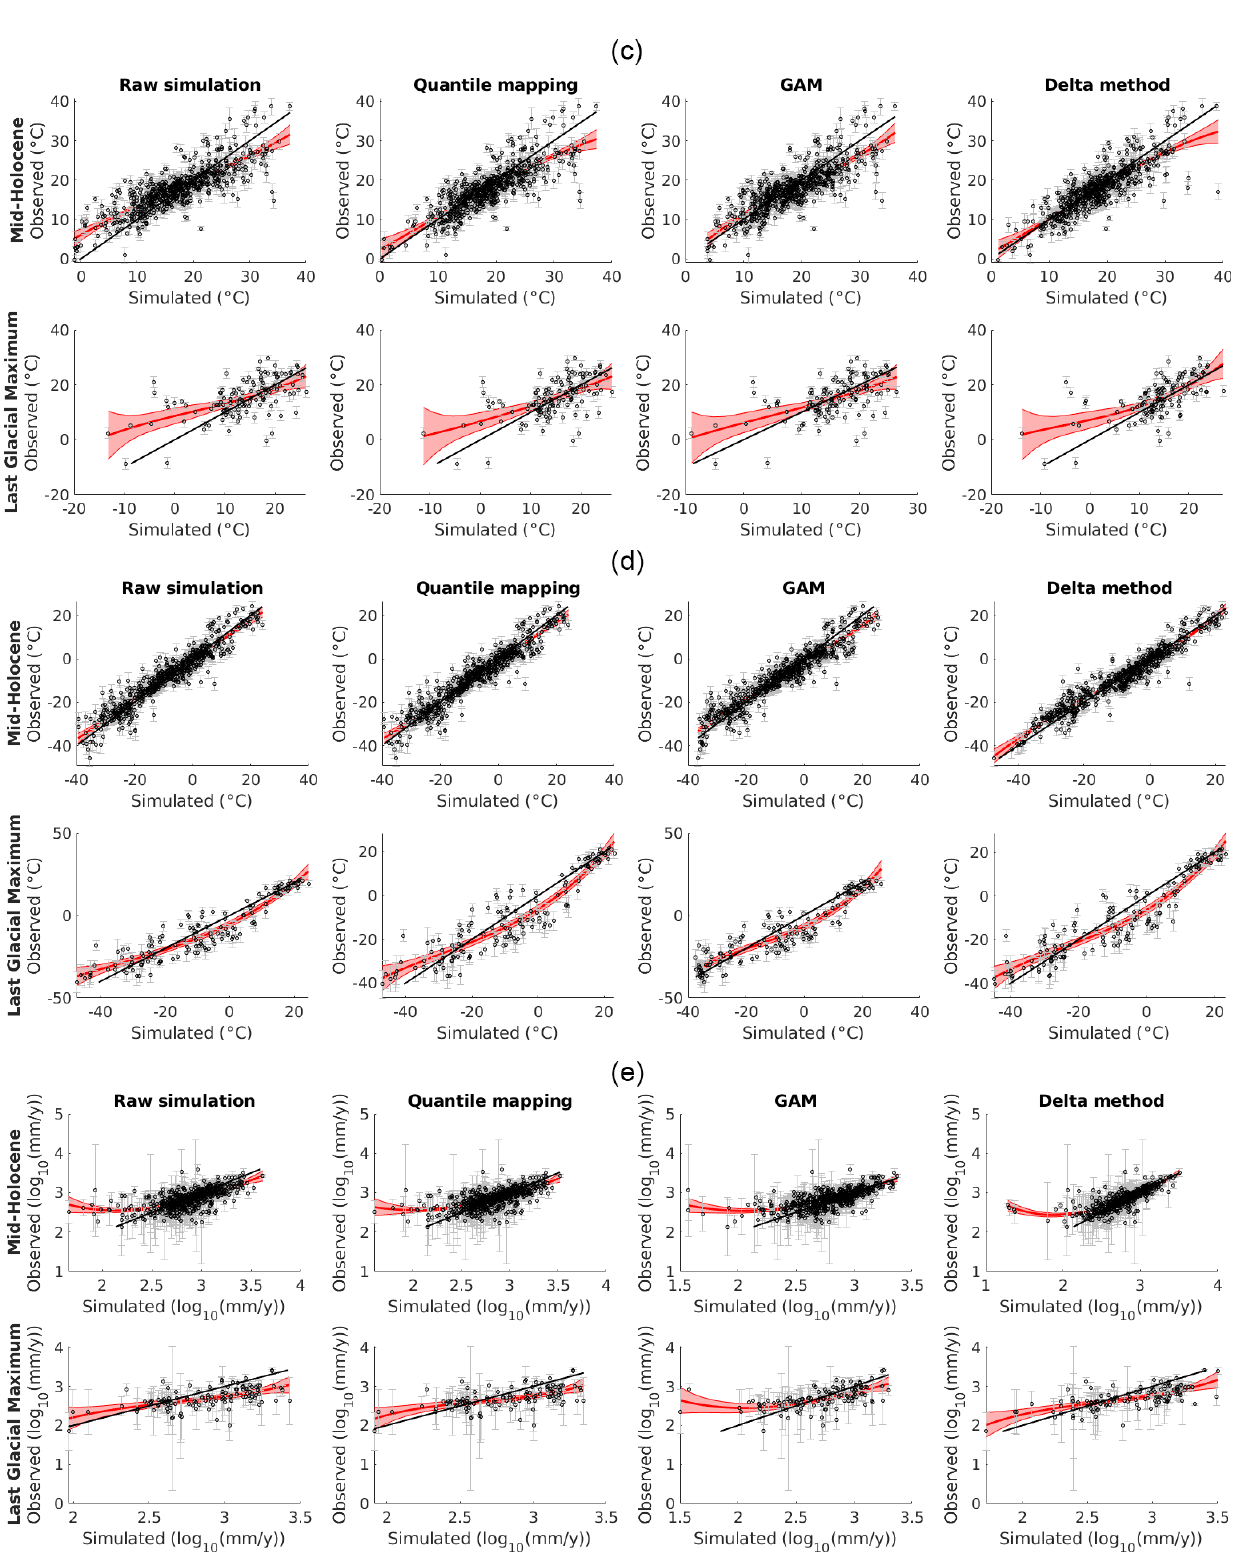
Figure 1. Comparison of bias-corrected simulated and empirically reconstructed climate variables. (a) Terrestrial mean annual temperature. (b) Marine mean annual temperature. (c) Mean temperature of the warmest month. (d) Mean temperature of the coldest month. (e) Annual precipitation. Black lines show 1:1 relationships. Red lines and shades show fifth-degree polynomial regressions and 95% confidence intervals,